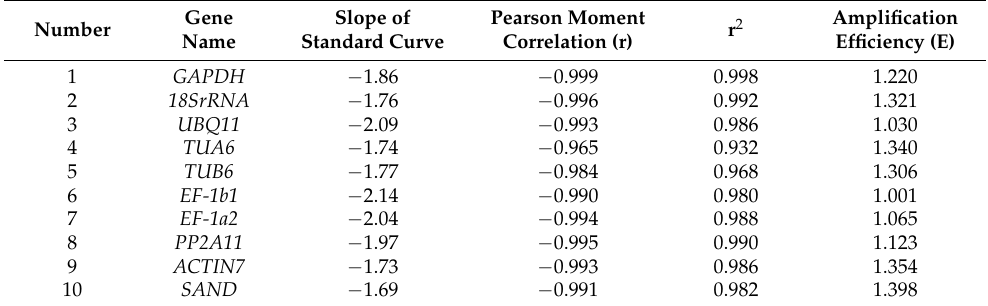
Table 2. Amplification correlation coefficients and amplification efficiency rates of candidate